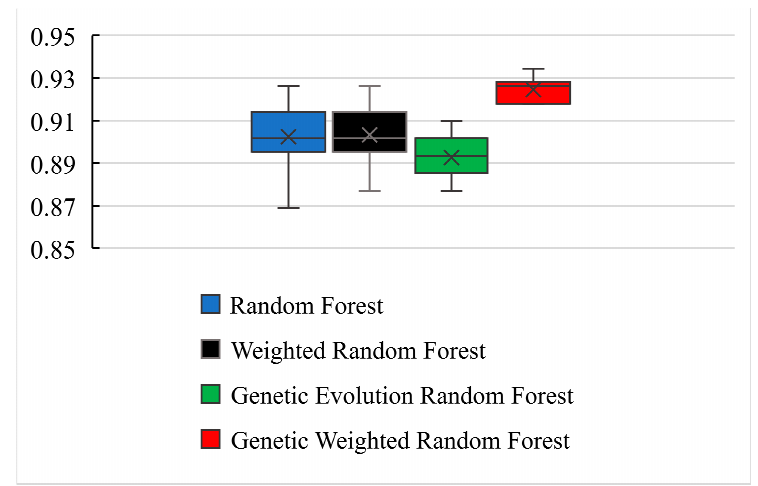
Figure 7. The ROC curves of the four models in S test .